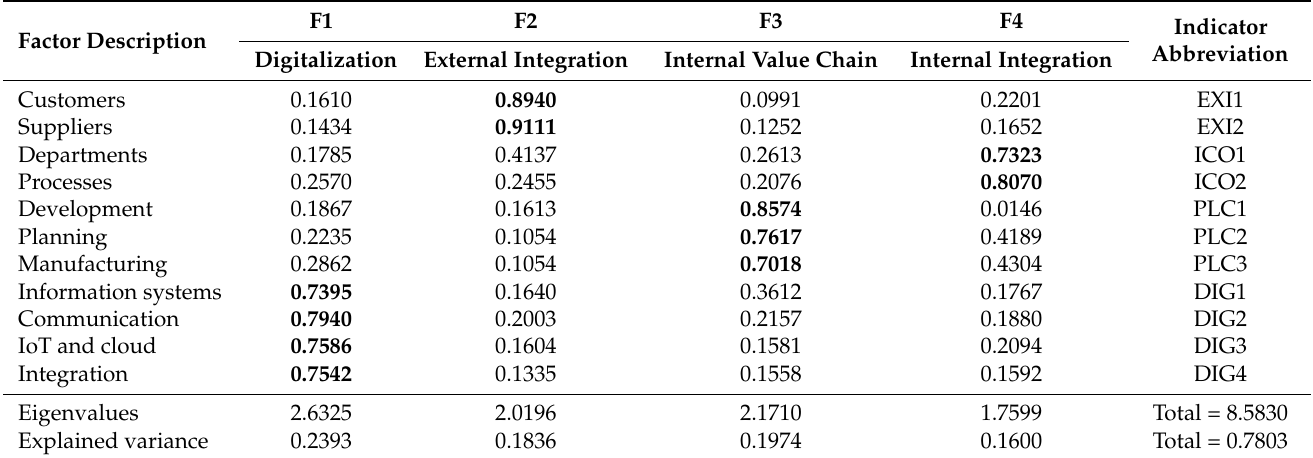
Table A1. Exploratory factor analysis results (Varimax